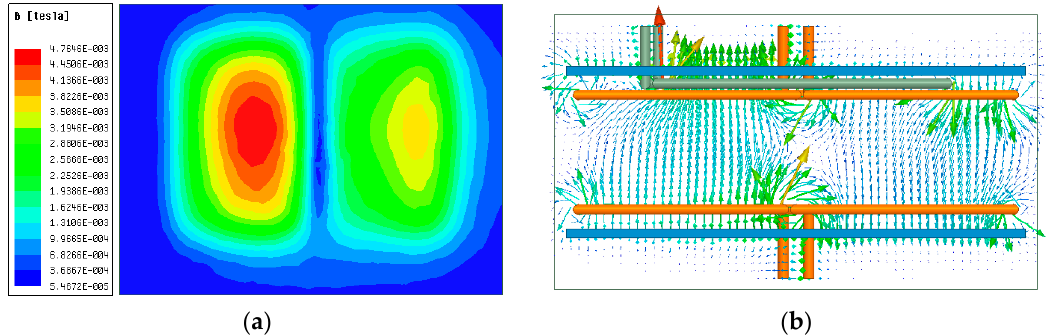
Figure 26. Magnitude plot ( a ) and vector plot ( b ) of the B field between Tx and Rx of the DD–DDQ configuration. DD–DDQ